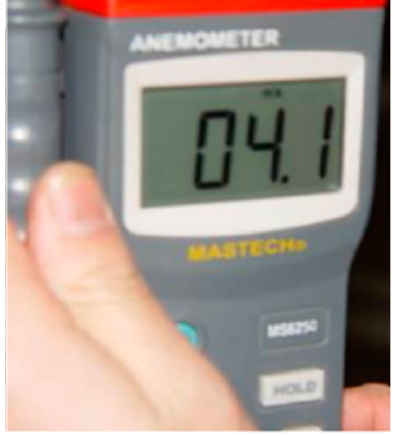
Figure 10. Anemometer.